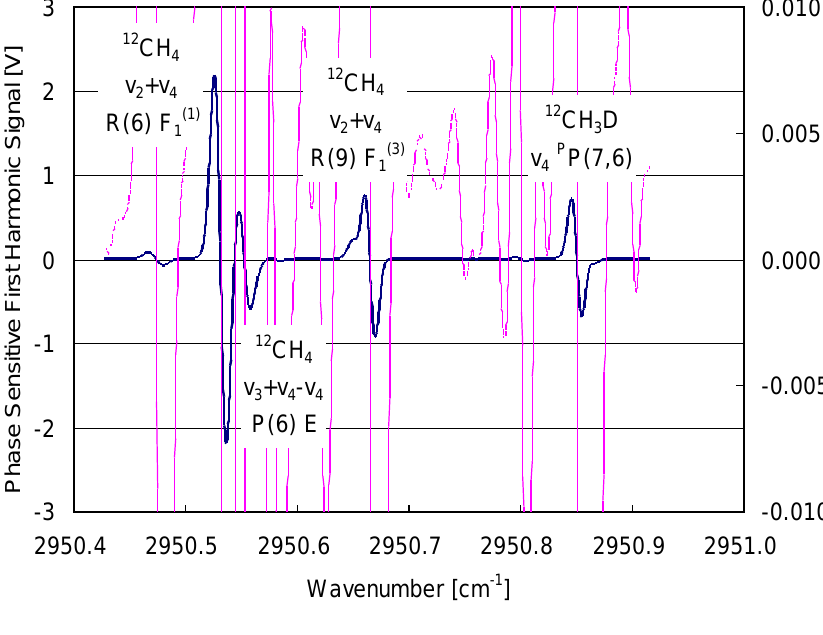
Figure 2. Recorded spectrum involving a suitable pair of 12 CH